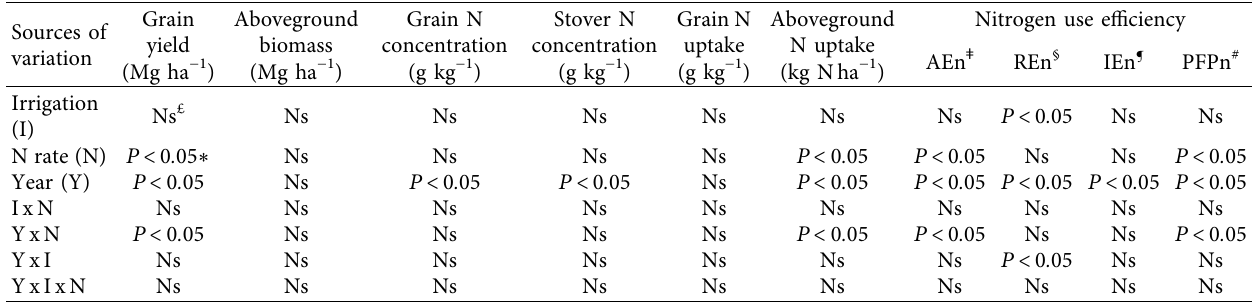
Table 5: Summary of ANOVA for grain yield, aboveground biomass, N uptake, and NUE with respect to N rates (0, 202, 269, and 336kgha -1 ), irrigation, and years (2014–2015) at TVREC.